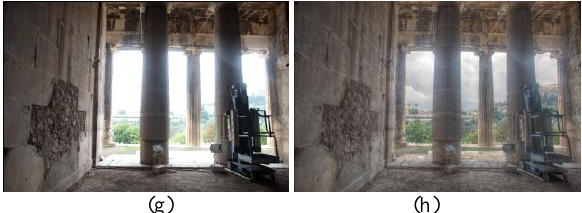
Figure 2: Scene 2, (a) – (g) 7 frames with exposure values from -3EV to +3EV (h) tone mapped image according to Mantiuk’s algorithm (Mantiuk et al., 2006).